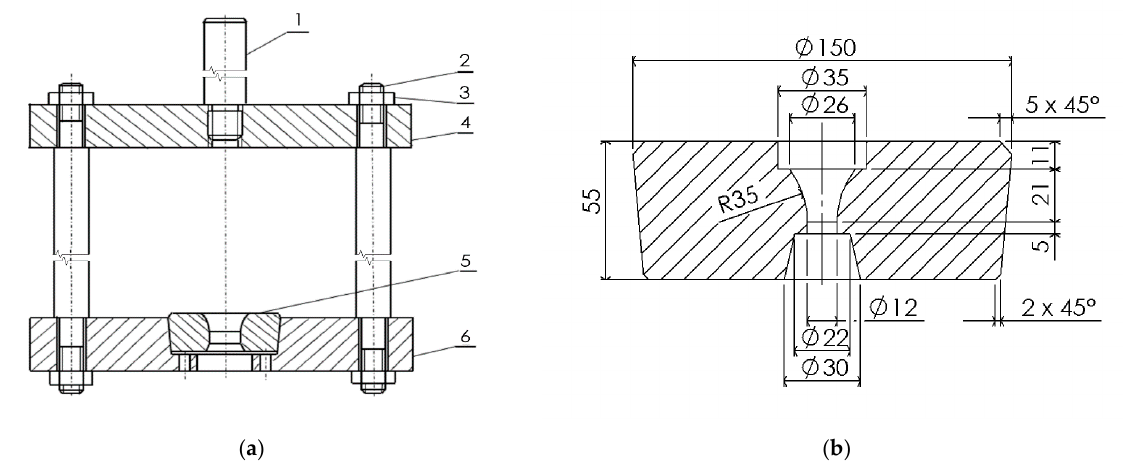
Figure 2. The equipment used for the cold tube drawing experiment. ( a ) The fixture for the cold tube drawing experiment: (1) clamping shank; (2) rod; (3) screw nut; (4) clamping plate; (5) die; (6) base plate. ( b ) The shape and dimensions of the drawing die.